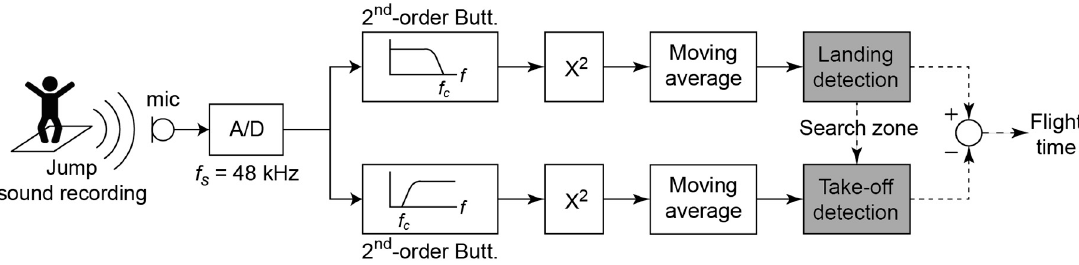
Figure 5. Block diagram of the signal processing algorithm. Solid arrows represent signal paths, whereas dashed lines represent information. A/D: Analog-to-digital converter.